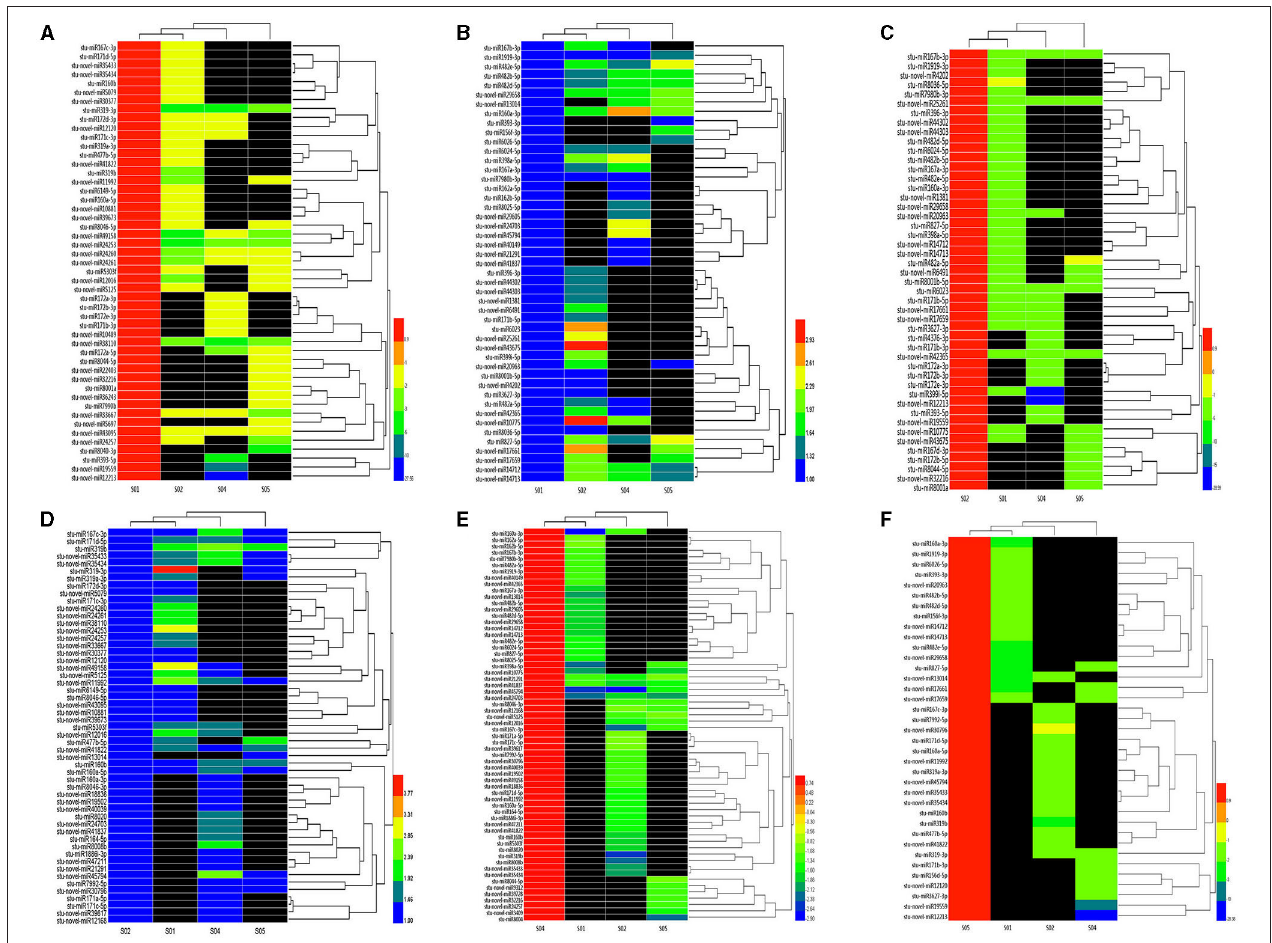
FIGURE 3 | Heatmap of DE miRNAs during cold stress in the potato. The color represents miRNA expression values (the red corresponds to sRNAs with high expression and the blue corresponds to sRNAs with low expression). S01, S02, S04, and S05 correspond to the libraries obtained in the temperature 20, 0, 2, and − 2 ◦ C respectively. (A) Up-regulation at 20 ◦ C but down-regulation at other 3 temperatures; (B) down-regulation at 20 ◦ C but up-regulation at other 3 temperatures; (C) up-regulation at 0 ◦ C but down-regulation at other 3 temperatures; (D) down-regulation at 0 ◦ C but up-regulation at other 3 temperatures; (E) up-regulation at 2 ◦ C but down-regulation at other 3 temperatures; (F) up-regulation at − 2 ◦ C but down-regulation at other 3